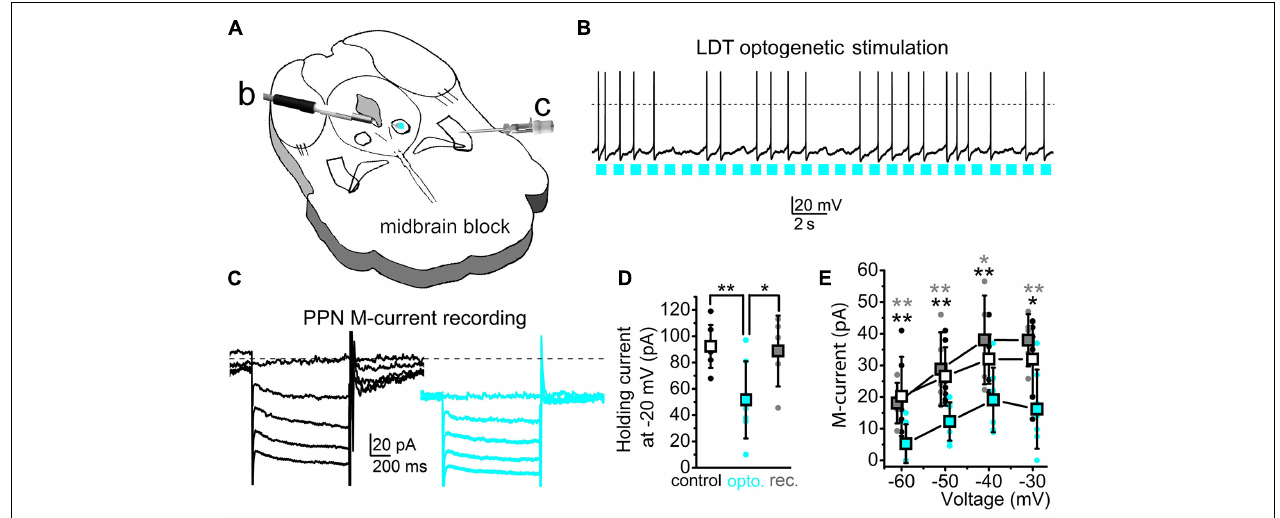
FIGURE 6 | Stimulation of a cholinergic PPN input can effectively reduce the PPN M-current amplitude. (A) Schematic drawing of the experimental arrangement. The laterodorsal tegmental nucleus (LDT) of the midbrain block prepared from a ChAT-ChR2 mouse was optogenetically stimulated [ blue spot : b ; see panel (B) ] in parallel with the patch-clamp recording from the PPN [ c ; see panel (C) ]. (B) Optogenetic stimulation of a cholinergic neuron in the LDT with 1 Hz pulsatile blue light ( blue squares ) and the consequential action potential firing of the activated neuron. (C) The M-current recorded from a PPN cholinergic neuron before ( black ) and during ( blue ) optogenetic stimulation of the LDT. Neurons were held at –20 mV and 1-s-long repolarizing steps were applied from –30 to –60 mV with a 10-mV decrement. (D) Statistical comparison of the holding currents at –20 mV voltage recorded before ( hollow squares and black dots ), during optogenetic stimulation ( blue squares and blue dots ), and after recovery ( gray squares and gray dots ). ** p < 0.010. (E) Statistical comparison of the repolarizing current steps recorded before ( hollow ), during optogenetic stimulation ( blue ), and after recovery ( gray ). Squares represent the mean ± SD and dots represent individual data. * p < 0.050; ** p < 0.010 ( black asterisks : significance between control and illuminated; gray asterisks : significance between the illuminated and recovered datasets). The decreases by optogenetic stimulation were 44.9 ± 14.9% at –60 mV, 48.5 ± 10.9% at –50 mV, 62.6 ± 12.5% at –40 mV, and 72.7 ± 24.2% at –30 mV ( n = 7). During recovery, compared to the control, current values were 104.6 ± 22.9% at –60 mV, 101.5 ± 4.8% at –50 mV, 113.3 ± 12.3% at –40 mV, and 128.3 ± 24% at –30 mV ( n = 5). Differences between the control and illuminated and between the illuminated and recovered datasets were statistically significant in all cases ( p =